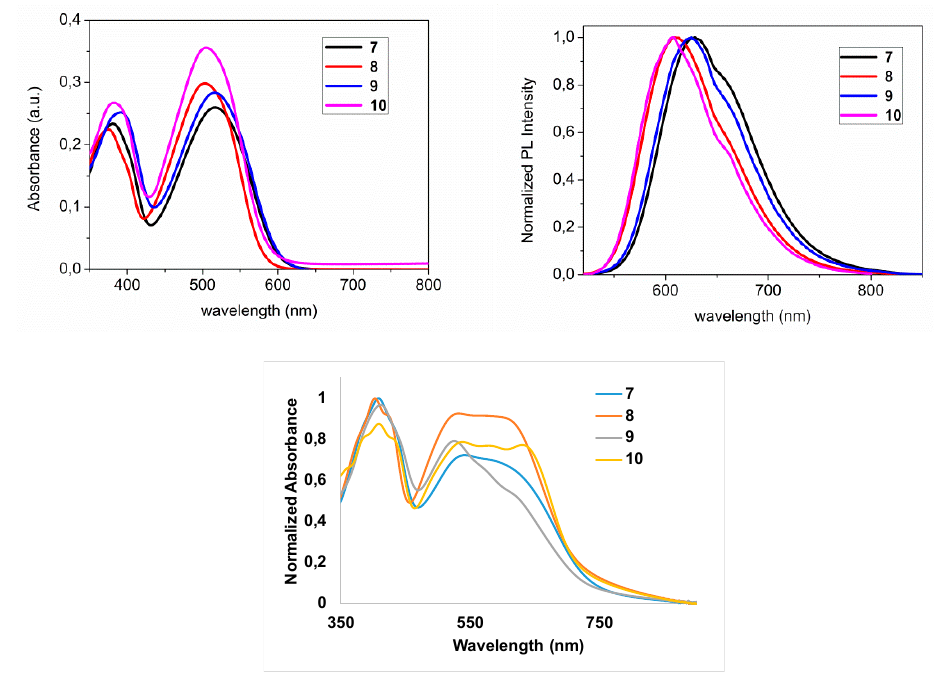
Figure 3. Absorption spectra (left), photoluminescence (PL) spectra (right) and solid state absorption spectra (bottom) of compounds 7 (black), 8 (red), 9 (blue), and 10 (violet) in DCM (10 − 5 –10 − 6